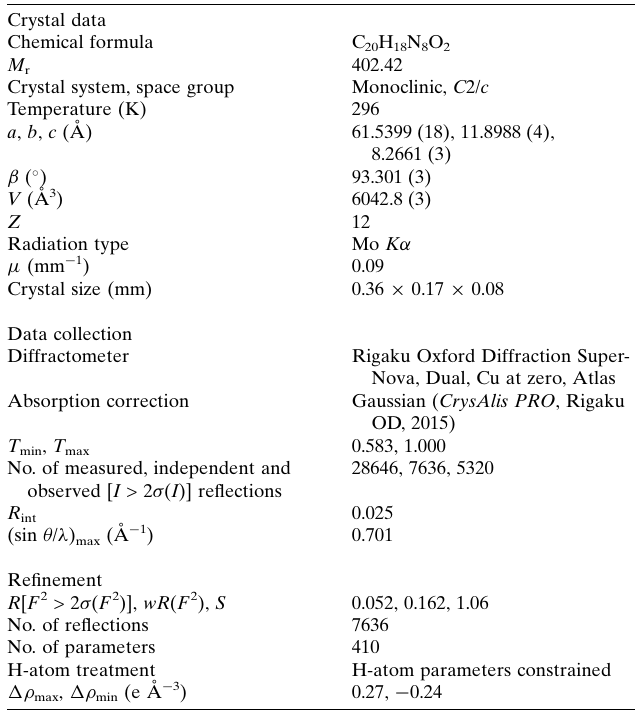
Table 2 Experimental details.